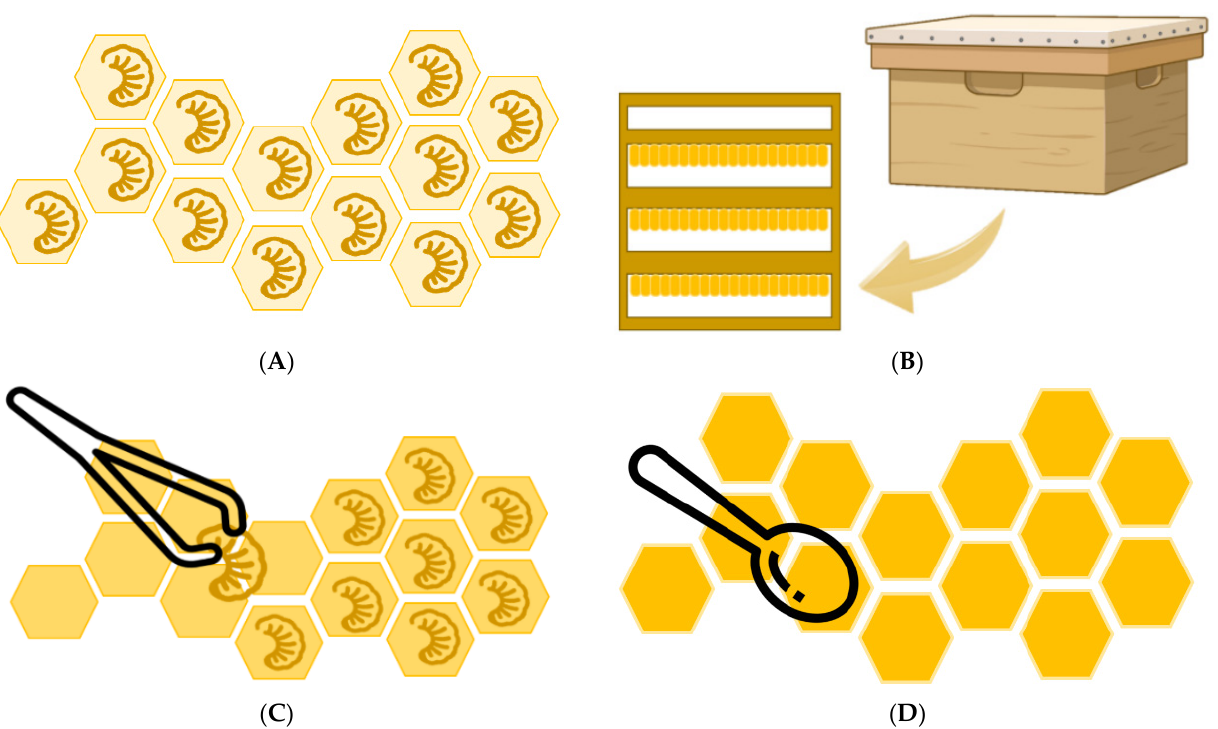
Figure 1. Royal jelly (RJ) production in royal cells inside a hive. ( A ) RJ production in queen cell base with worker bee larvae inside. ( B ) Hive for breeding honeybees and queen bees for RJ production. ( C ) Removal of worker larvae from royal cells. ( D ) Collection of RJ from the